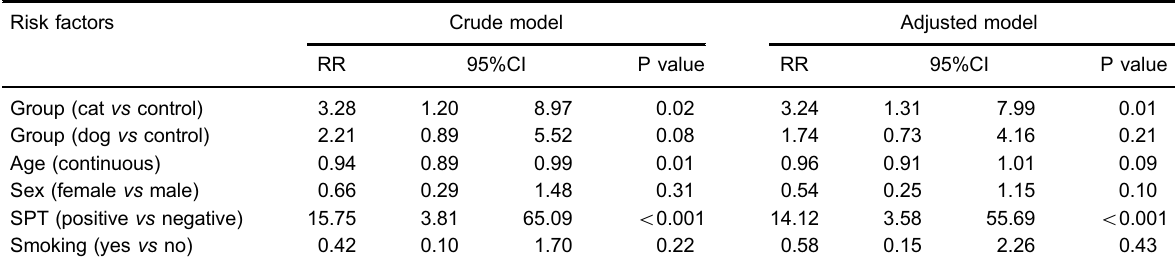
Table 2. Assessment of risk factors for con fi rmed asthma.